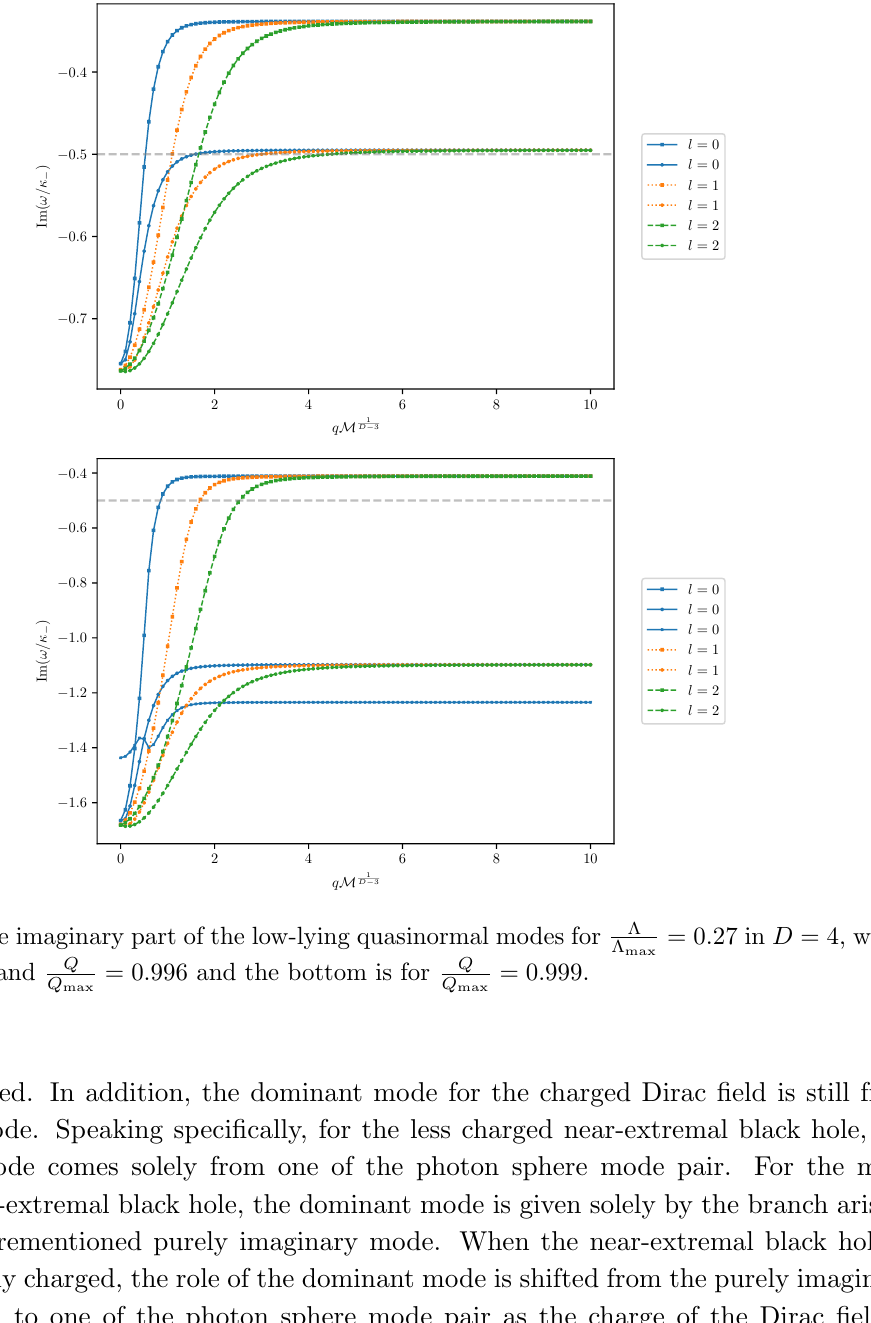
(cid:12)eld is charged. In addition, the dominant mode for the charged Dirac (cid:12)eld is still